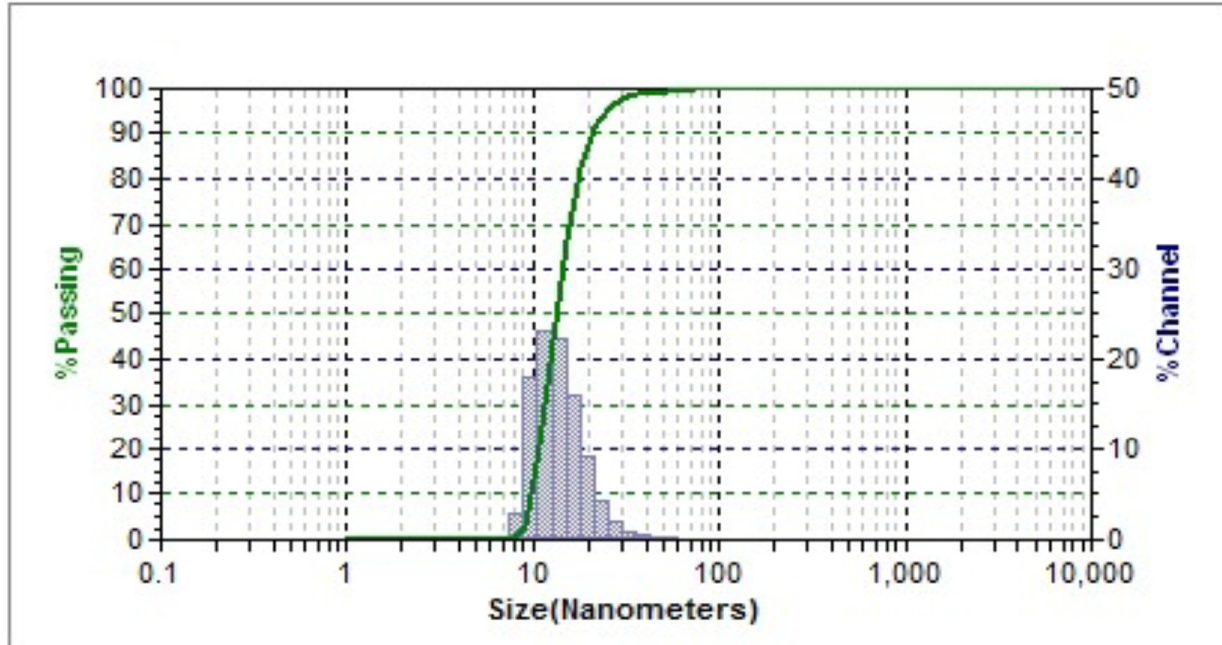
Figure 4. Transmission electron microscope analysis of CUNE sample.